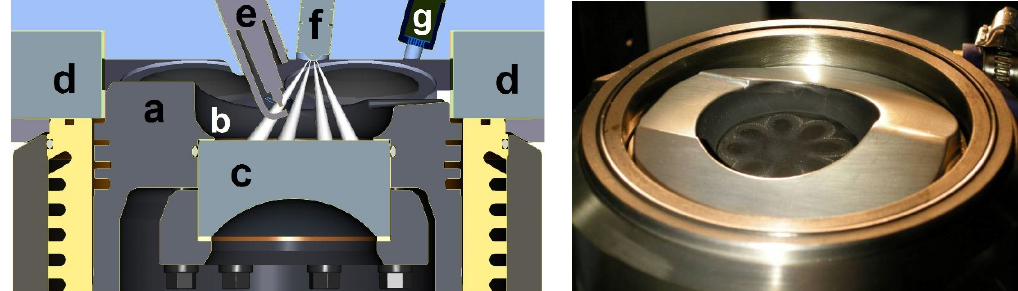
Figure 2. left: scheme of the cross-section of combustion chamber at TDC with ( a )—piston, ( b )—piston bowl, ( c )—piston- bowl quartz window or metal blank, ( d )—pent-roof quartz window or metal blank, ( e )—spark plug, ( f )—fuel injector, and ( g )—pressure transducer; right: Picture of all-metal piston and cylinder.